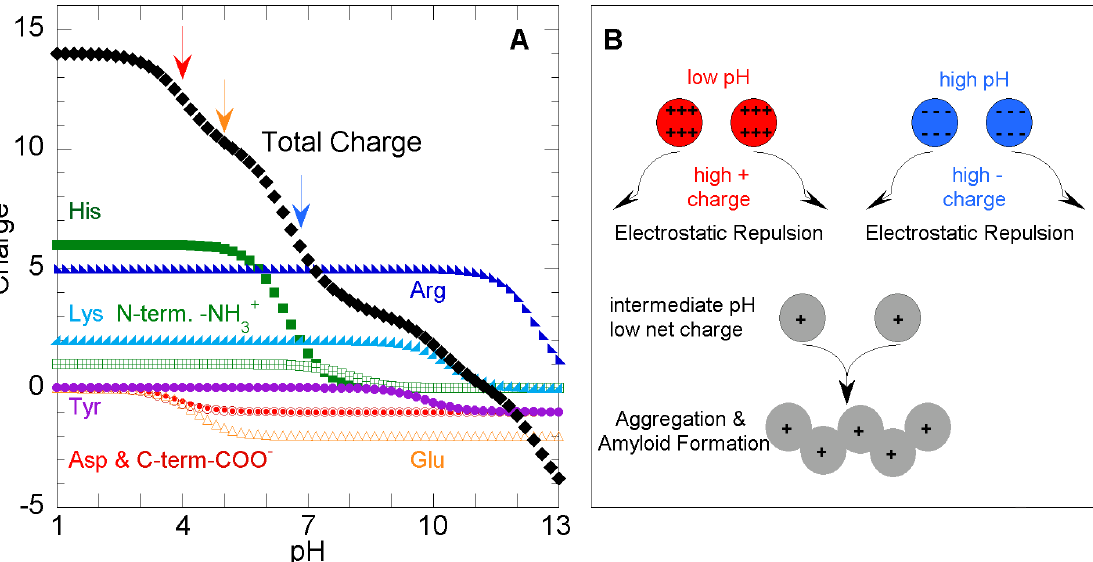
Fig 2. Electrostatic repulsion modulates the aggregation of TDP-43 ’ s C-terminal domain. A . Calculated total net charge (black diamonds) on the TDP- 43 C-terminal domain (CTD) as a function of pH. The contributions of different types of titratable groups are shown as colored symbols (C-terminal carboxylate = red open circles, Asp 406 = small red circles, Glu 271 and 362 = gold open triangles, His 264 and hexaHis tag = green squares, N-terminal amine = open crossed green squares, Tyr 374 = purple circles, Lys 263 and 408 = sky-blue triangles, and Arg 268, 272, 275, 293, and 361 = blue triangles. The red, gold, and blue arrows mark the net charge at pH 4 (+12.1), pH 5 (+10.3), and pH 6.8 (+6.0). The underlying data are shown in S1 Data, columns K – U. B . Model for the electrostatic control of amyloid formation. At pH extremes, polypeptides carry a high positive or negative net charge. The resulting unfavorable charge – charge interactions impede association. At intermediate pH values, the net charge is low and electrostatic repulsion is too weak to prevent oligomerization and amyloid formation, which is favored by strong hydrogen bond networks, hydrophobic interactions, or both.